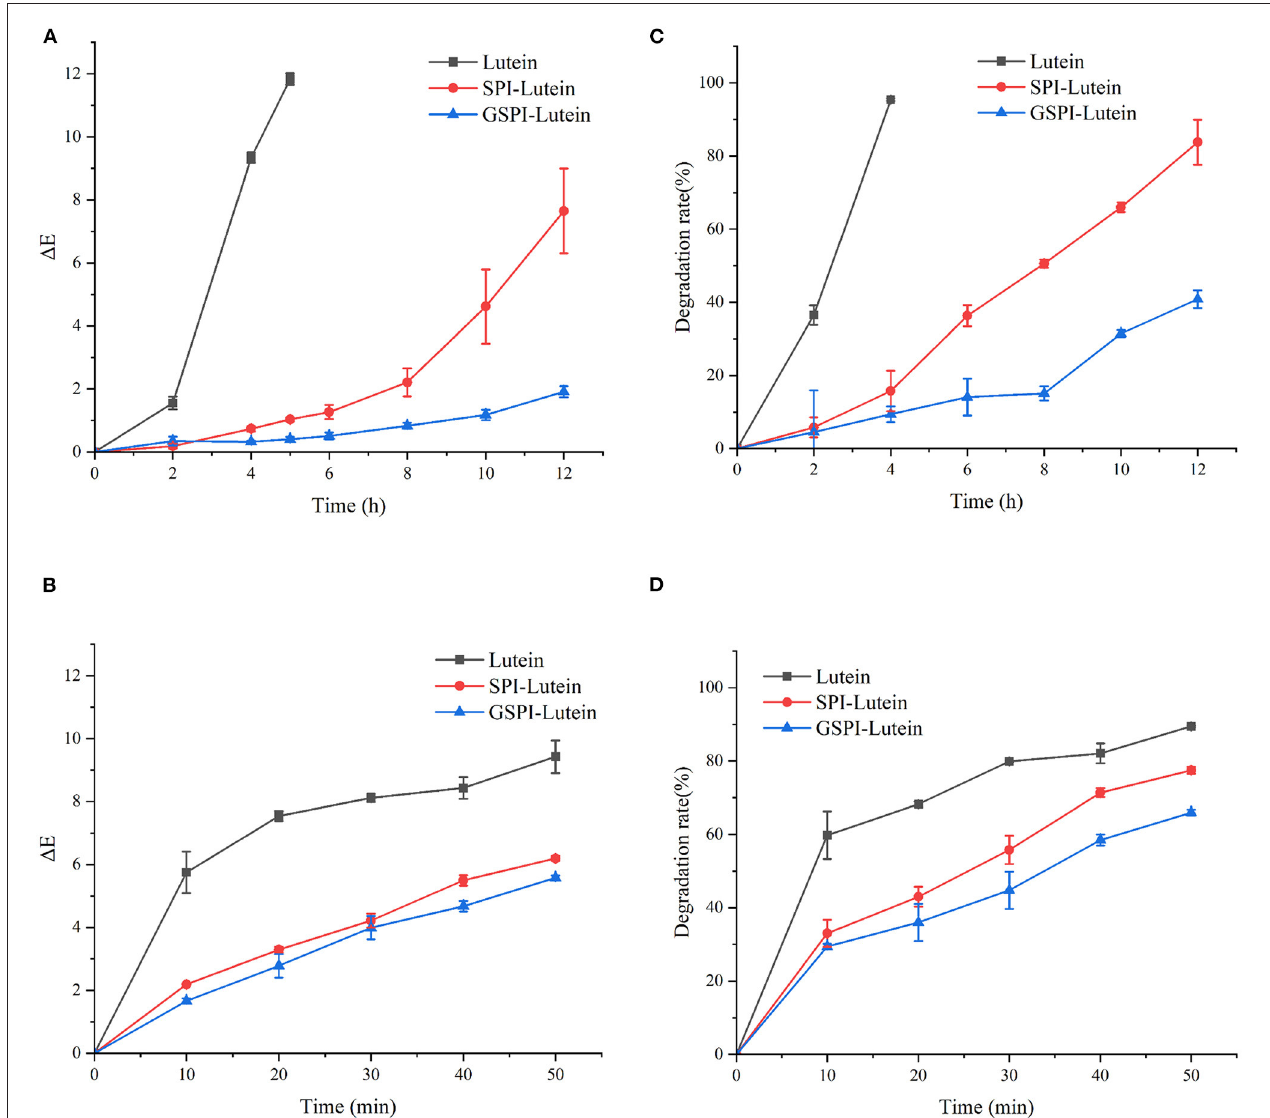
FIGURE 7 | Stability analysis of lutein, SPI–lutein and GSPI–lutein. (A) Total color difference under light conditions. (B) Total color difference under heating conditions. (C) Degradation rate under light conditions. (D) Degradation rate under heating conditions.